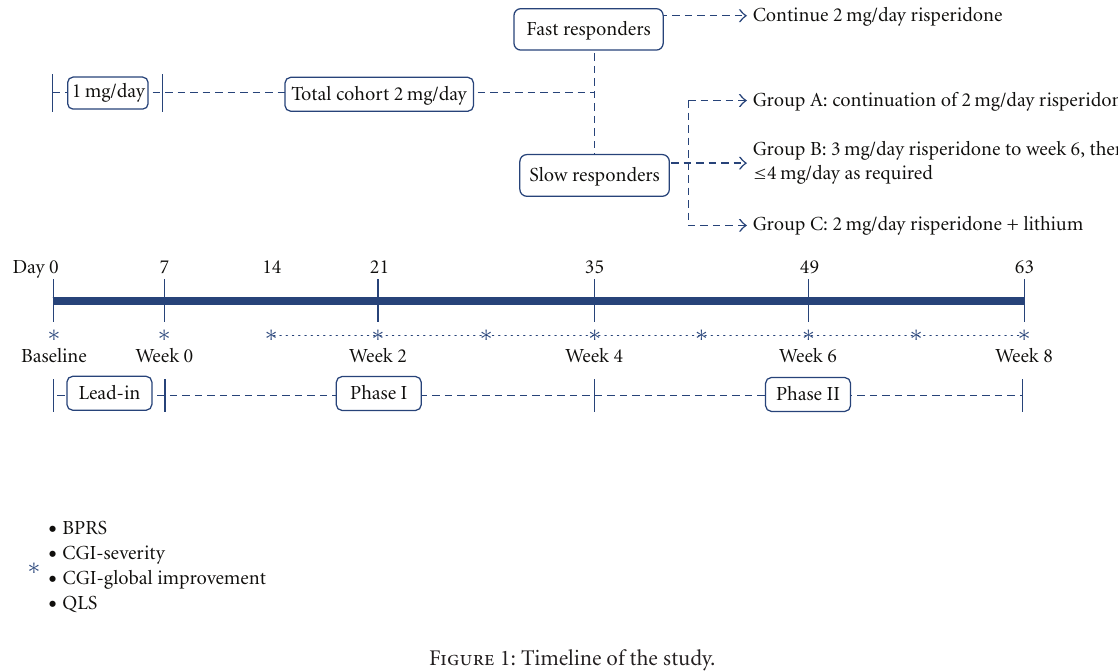
Figure 1: Timeline of the study.